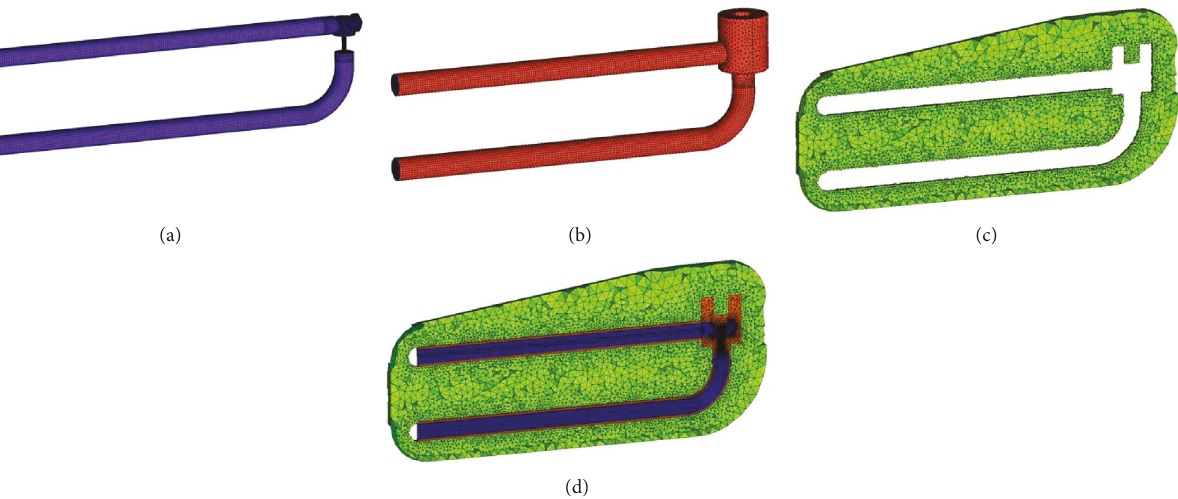
Figure 4: Acoustic computational meshes: (a) In-pipe fluid domain, (b) Pipe solid domain, (c) Out-pipe air domain, and (d) Complete acoustic meshes profile.